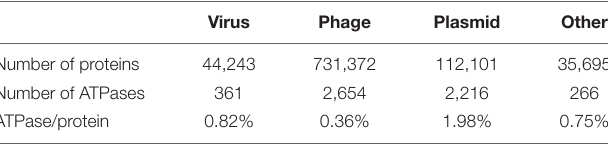
TABLE 2 | Percentage of ATPase per protein by category in the mobilome